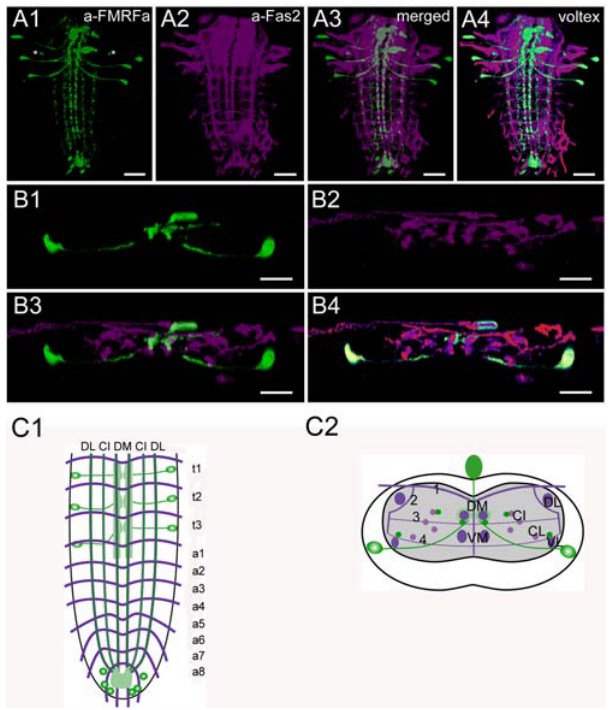
Figure 7. Morphology of FMRFamide neurons. Mapping of FMRFa-IR neurons in whole-mount preparations of the thoracic and abdominal neuromeres of L3 larva in the Fas2 landmark system. A) Dorsal view. B) Transversal view at the height of neuromere t2. C) Idealized dorsal scheme. D) Idealized transverse scheme. Scale bars: 50 m m in A) , 25 m m in B ). Immunostaining is shown in green, Fas2 in magenta.